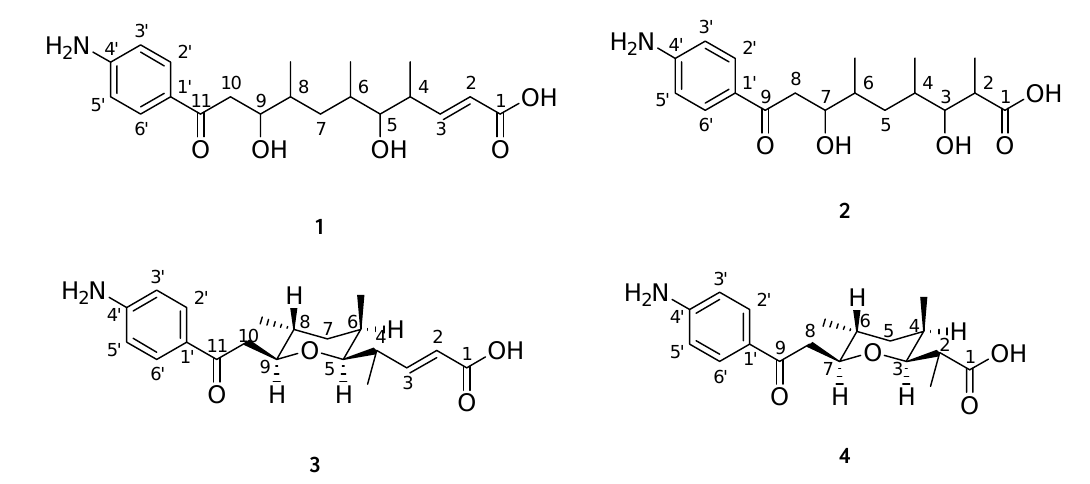
Figure 1. New p -aminoacetophenonic acids 1–4